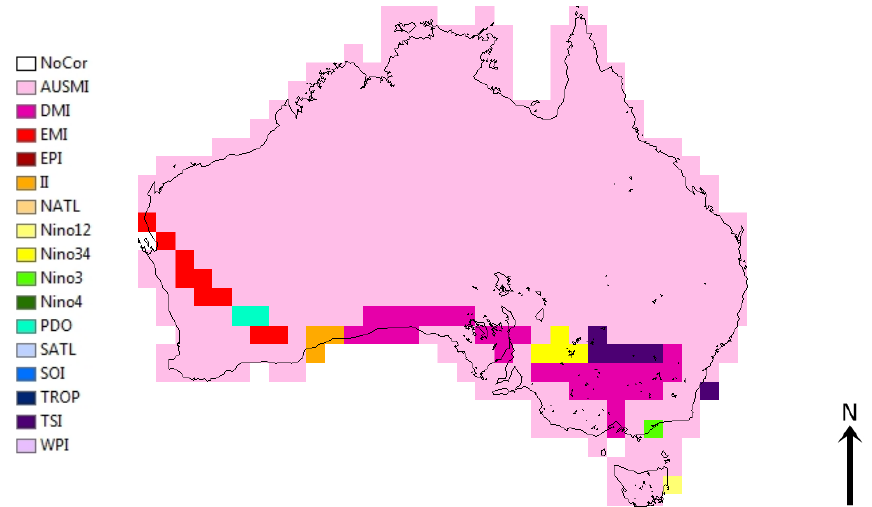
Figure 5. Map showing the climate index that correlates most strongly with monthly total rainfall over Australia between 1900 and 2010. Data aggregated to a resolution of 1.25 ° by 1.25 ° (approximately 125 km by 125 km). All coloured grid cells show correlations that are significant at the 95% significance level.